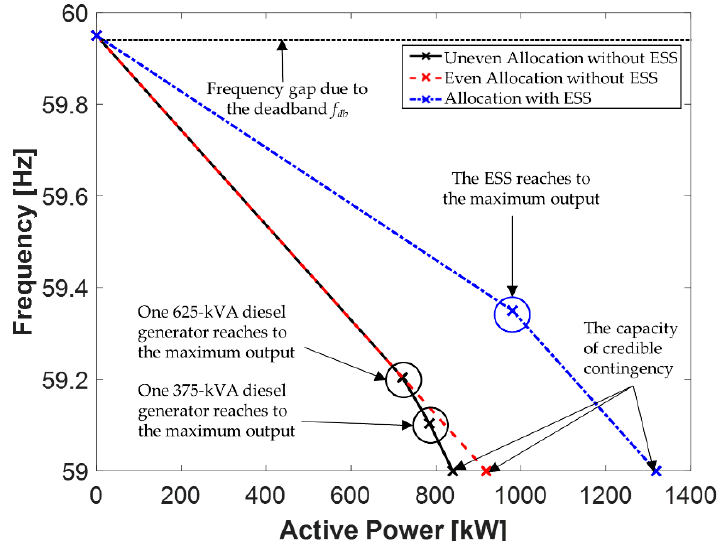
Figure 3. Dynamic droop curves for the microgrid with three different power allocation strategies.